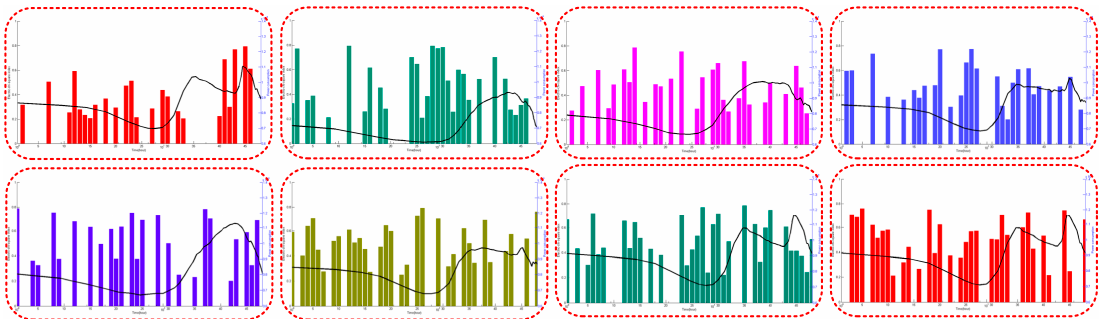
Figure 5. The employed data in Experiment II.